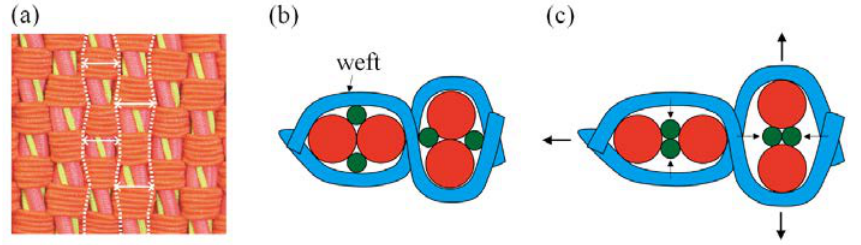
Figure 9. Ideal arrangement of two neighboring 4-ply auxetic yarns: ( a ) at zero strain; ( b ) under tension.